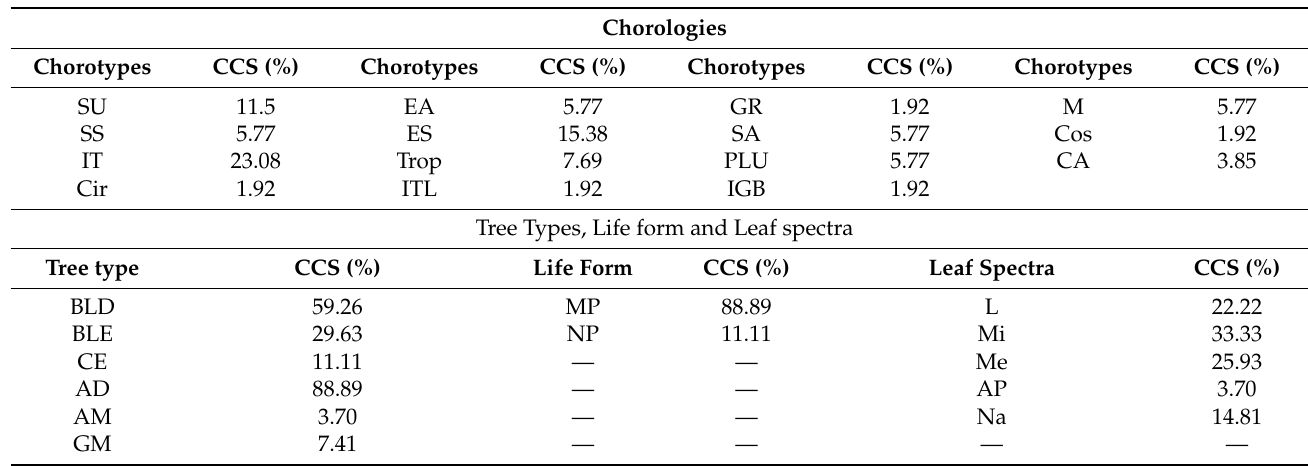
Table 3. Summary of chorologies, tree type, life form, and leaf spectra of the documented tree species.